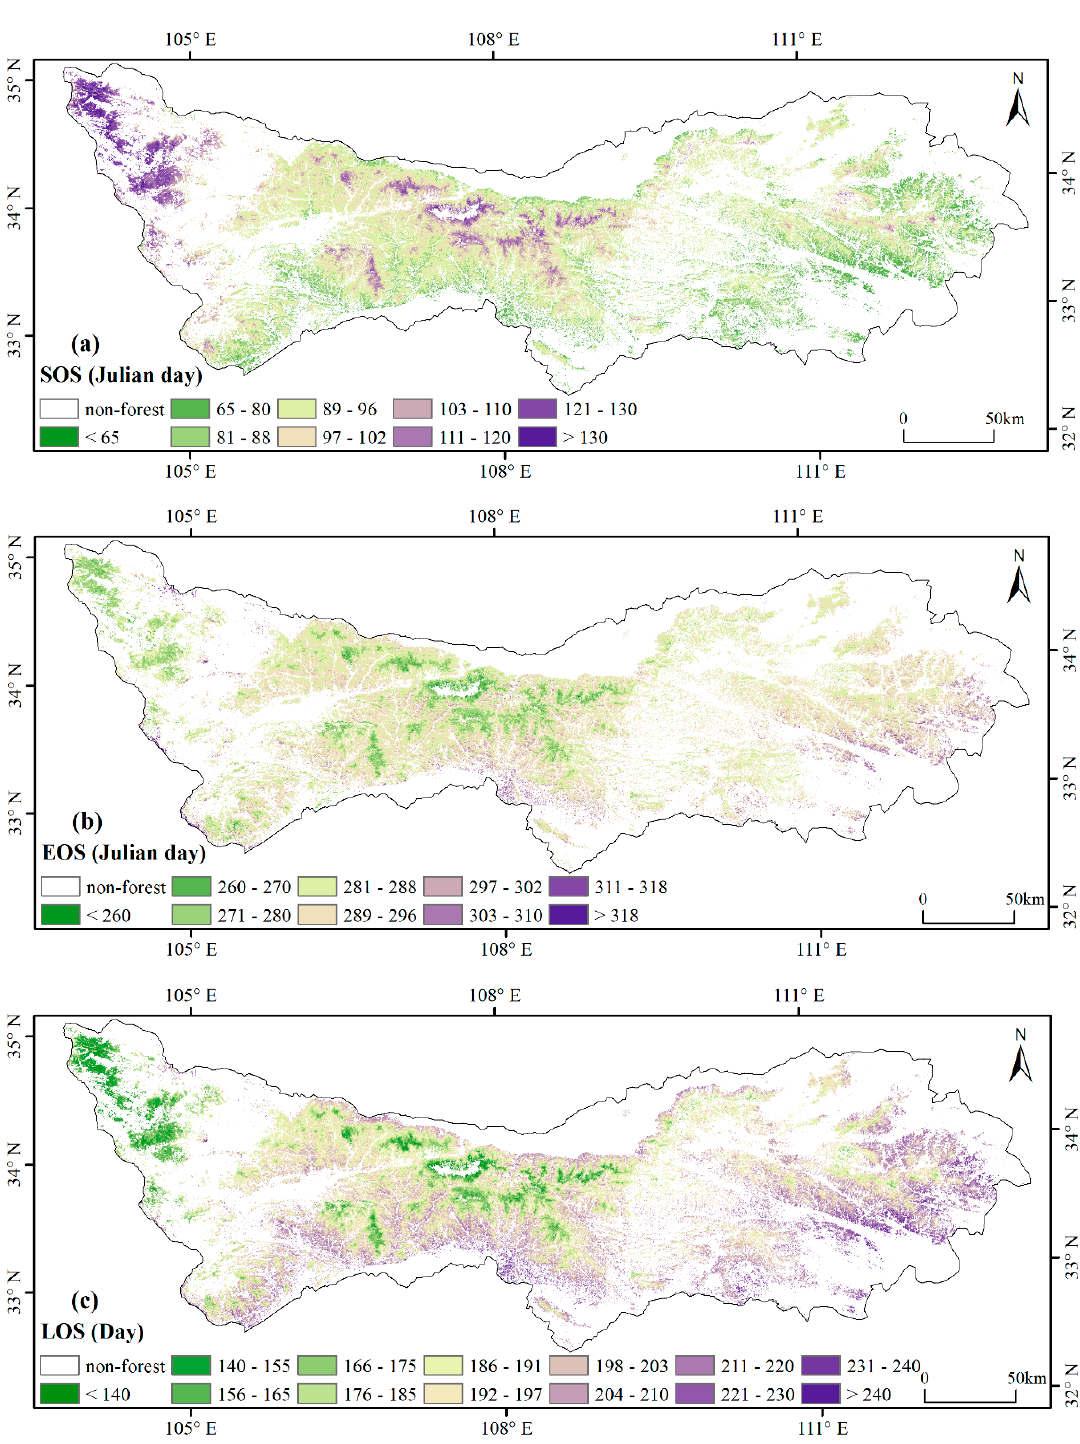
Figure 2. Spatial patterns of phenology metrics, including the start of the growing season start of growing season (SOS) ( a ), the end of the growing season end of growing season (EOS) ( b ), and the length of the growing season length of growing season (LOS) ( c ), across the Qinling Mountains (QMs) during 2001–2017.